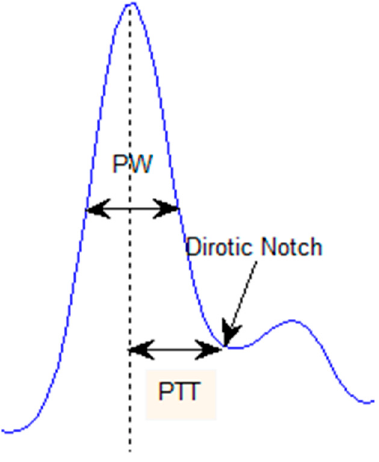
Figure 3. A display of PW, PTT and dicrotic notch.